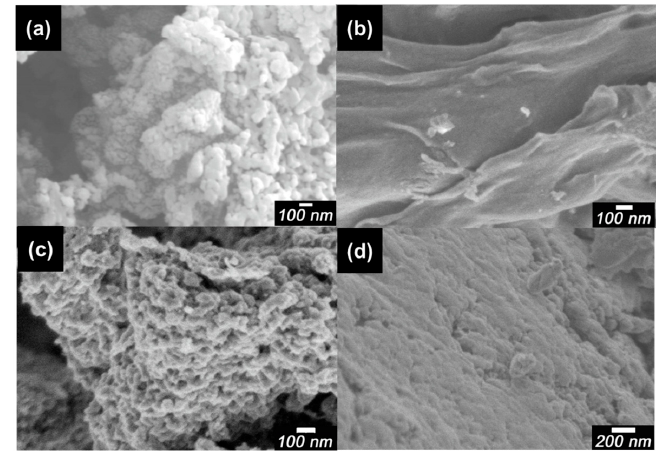
Figure 10. SEM images of carbonized pure PANI ( a ); dried CNF ( b ); PA-NF4 ( c ); and PA-NF5 ( d ).